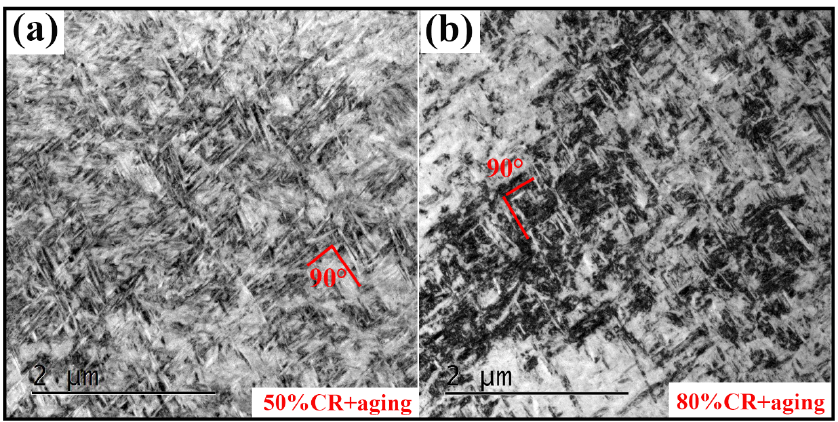
Figure 7. High-magnification TEM images of samples ( a ) 50% + aging and ( b ) 80% + aging.